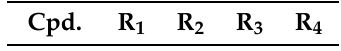
Figure 11. Structure of compound 144 .